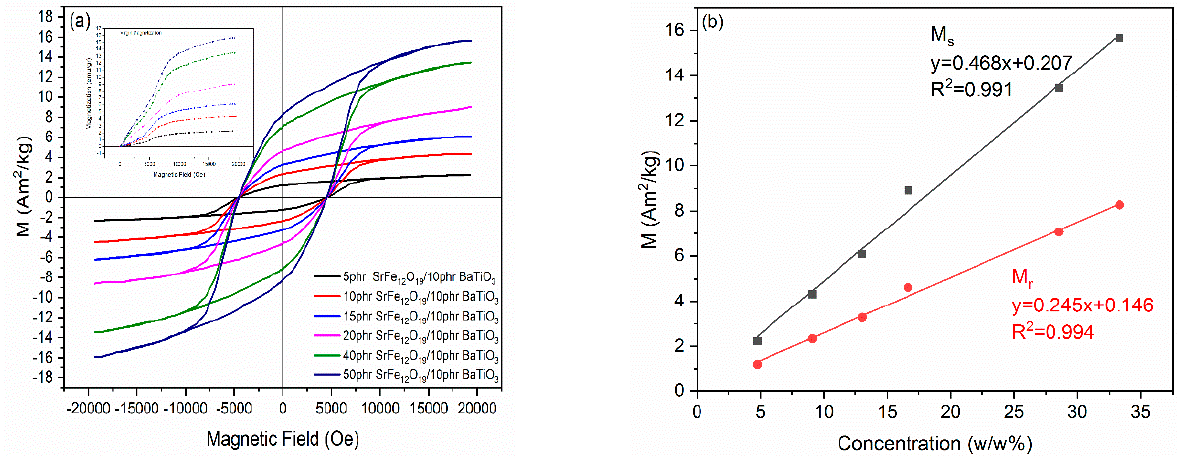
Figure 12. ( a ) Magnetic hysteresis loops for the nanocomposites with varying SrFe 12 O 19 content. ( b ) The variation of magnetic saturation ( M s ) and magnetic remanence ( M r ) as a function of magnetic filler content.